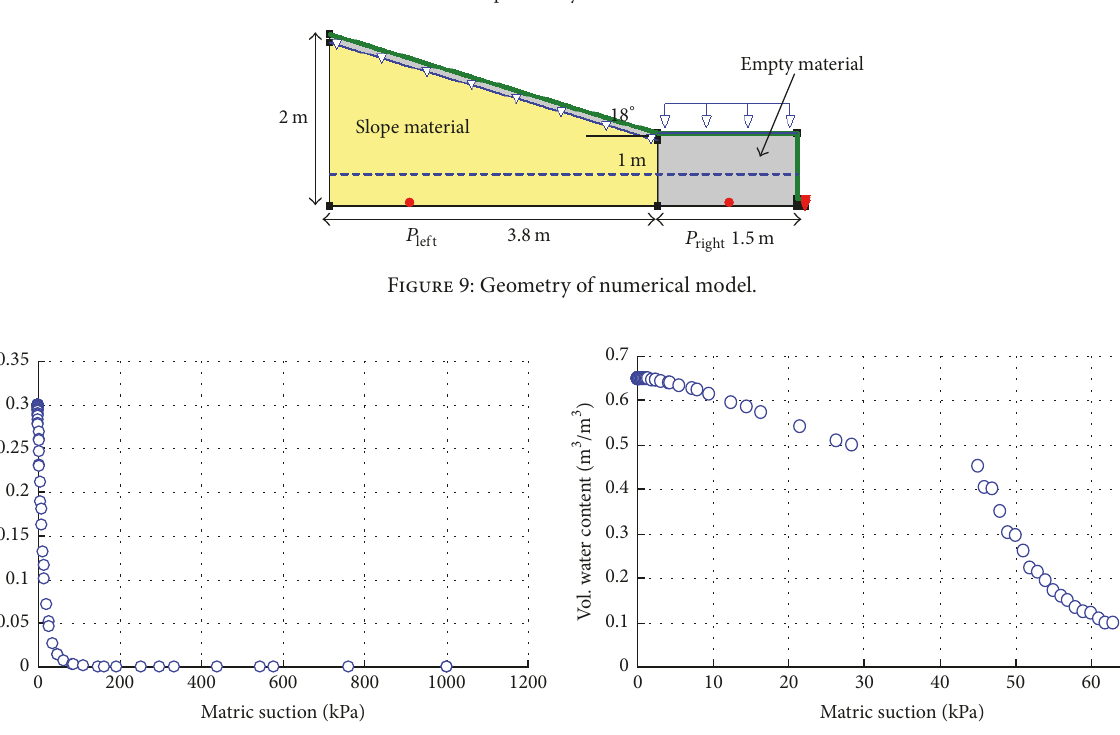
It is found that the parameters basically reflect the change of the PWP trend.